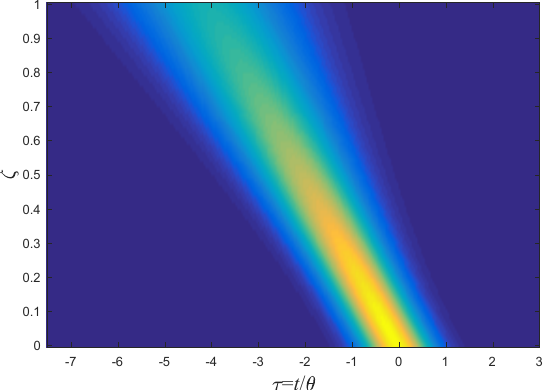
Figure 3. The real (upper panel) and imaginary (lower panel) components of the Gaussian pulse (Equation (16)). The dashed curve represents the initial profile (for 0/ 2 curve represents its final shape (for 2/ 2  /4 0